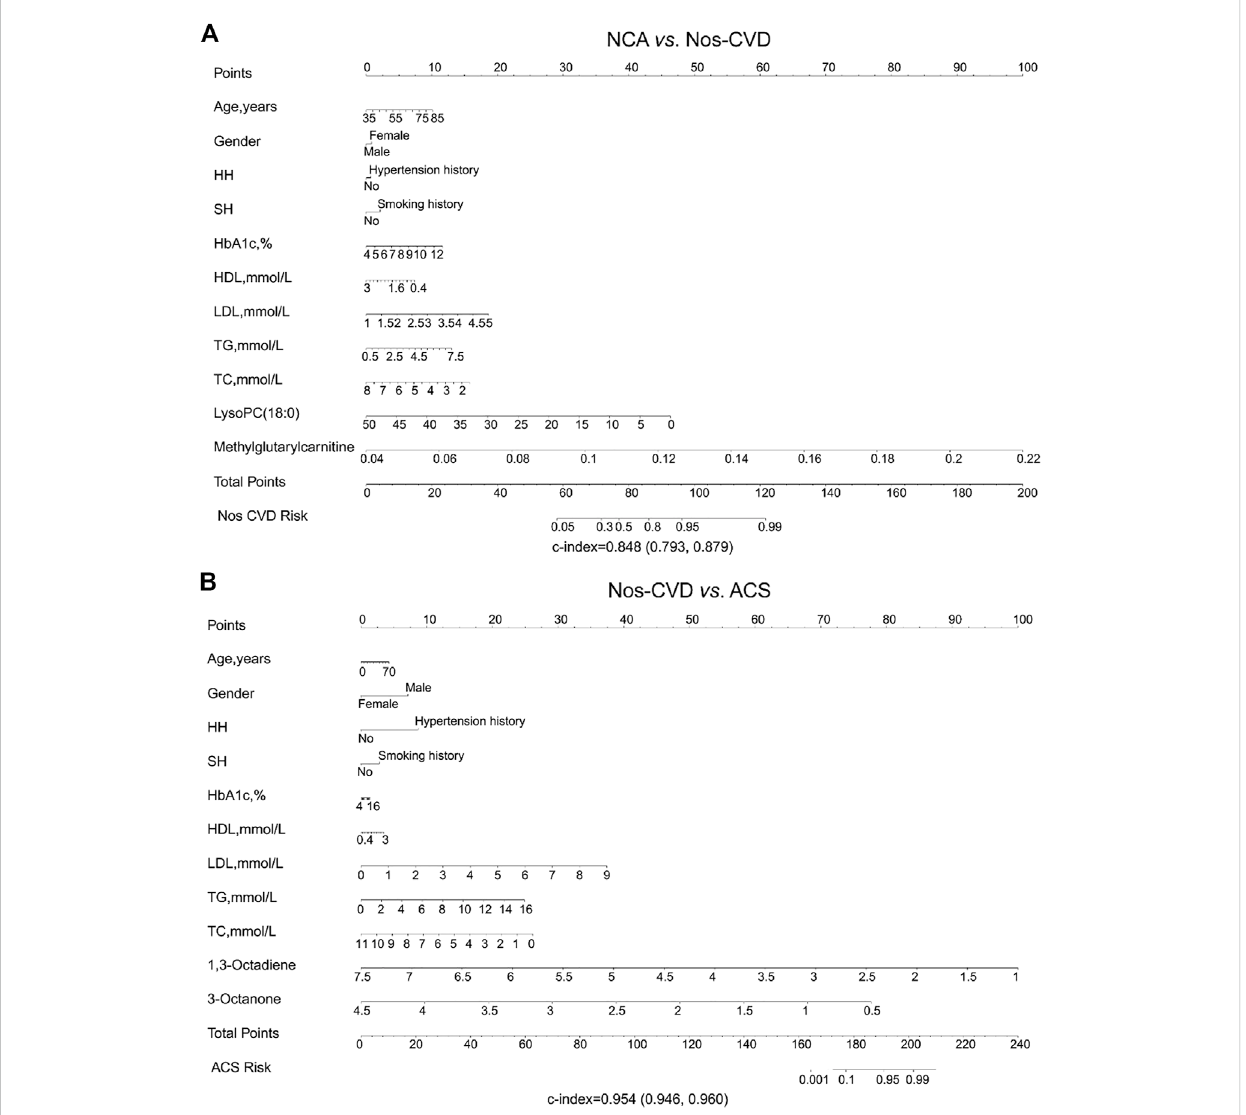
FIGURE 4 Nomogram depicting cardiovasculardisease (CVD) risk among diabetics (A) Risk prediction for normal coronaryartery (NCA) versus non-signi fi cant cardiovascular diseases (nos-CVDs) by metabolic marker-assisted model (B) Risk prediction for nos-CVDs versus acute coronary syndrome (ACS) by metabolicmarker-assistedmodel.ToobtainthepredictedprobabilityofCVDriskafterdiagnosisofdiabetes,thepatientvalueswerelocatedoneachaxis. A vertical line wasdrawn upwardto the ‘ Points ’ axisto determinethepoints ofthevariable. The points for all variables weresummedandlocated on the ‘ Total points ’ axis. A vertical line was drawn down to the ‘ Nos-CVDs or ACS risk ’ axis to fi nd the patient ’ s probability of different CVDs